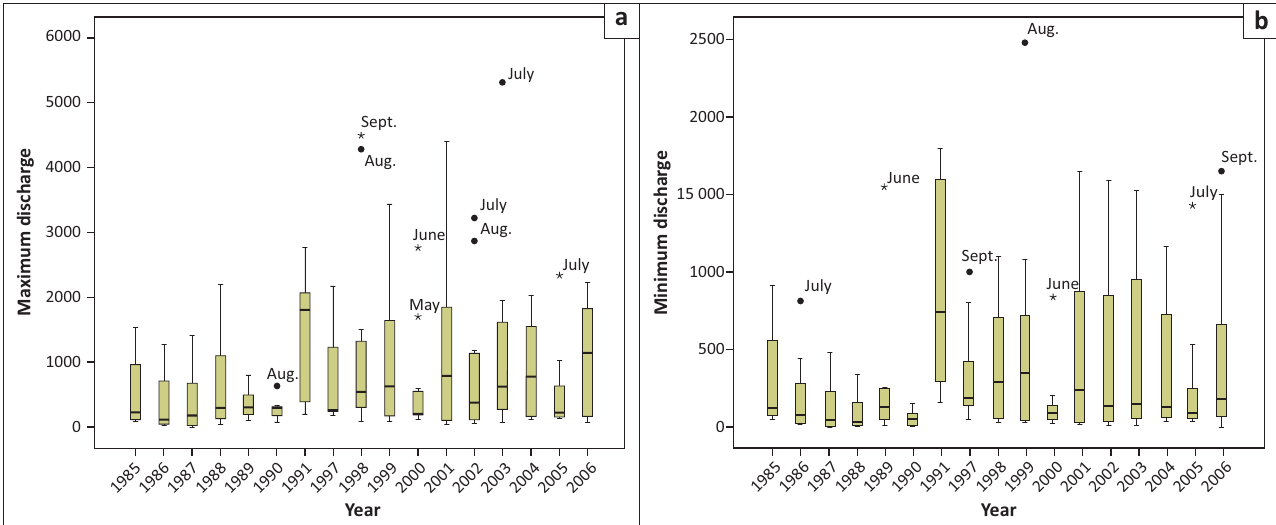
FIGURE 8: Box plot of year-wise recorded (a) maximum and (b) minimum discharge at Dalia station from 1985 to